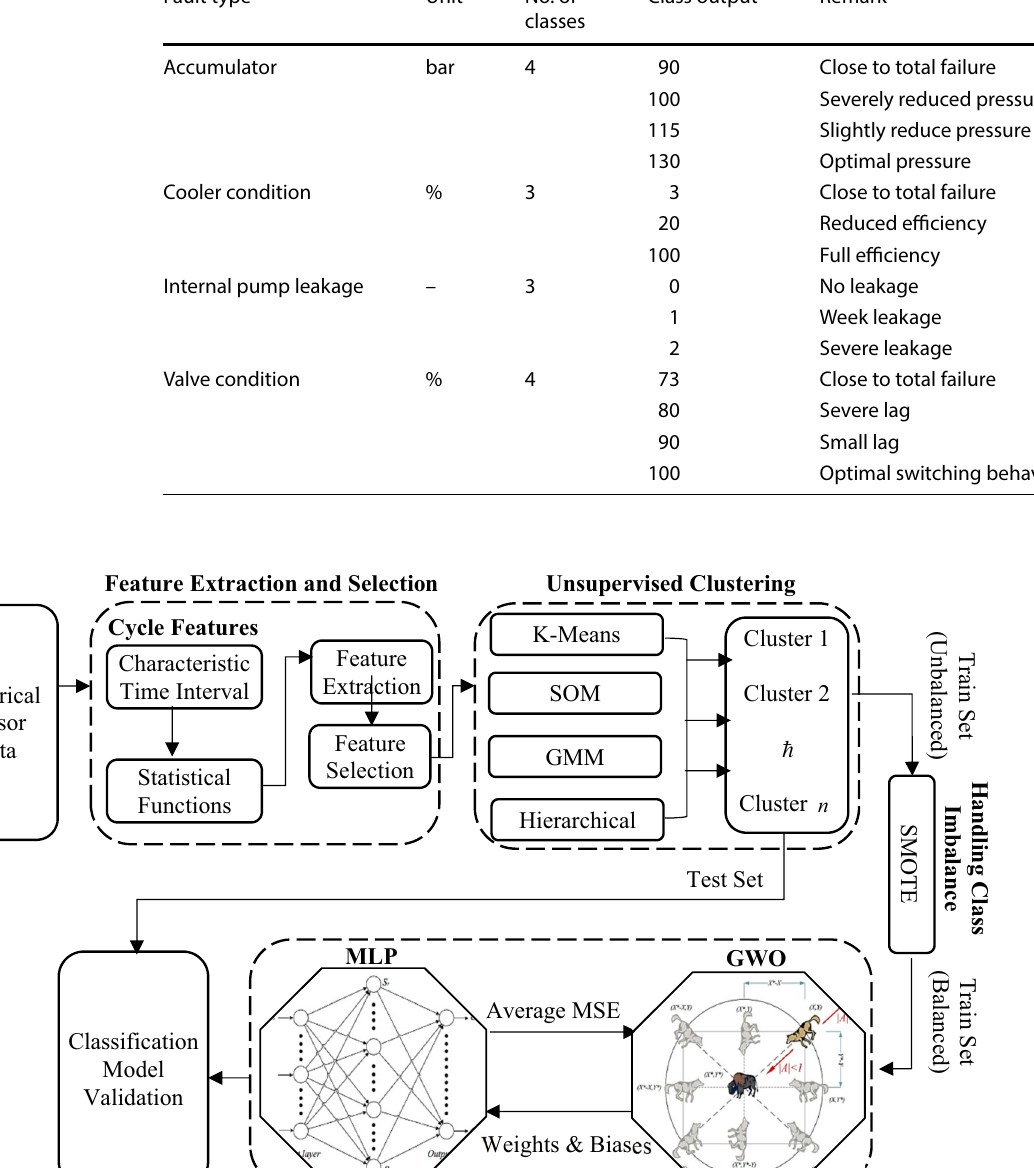
Table 1 Details of fault components